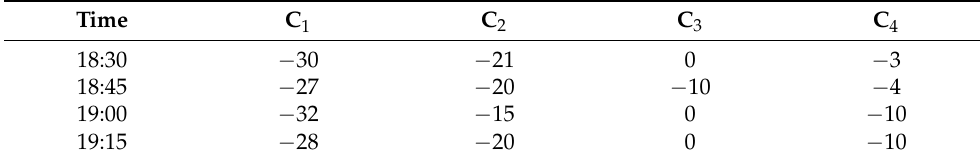
Table 3. Individual consisting of a sequence of four operational